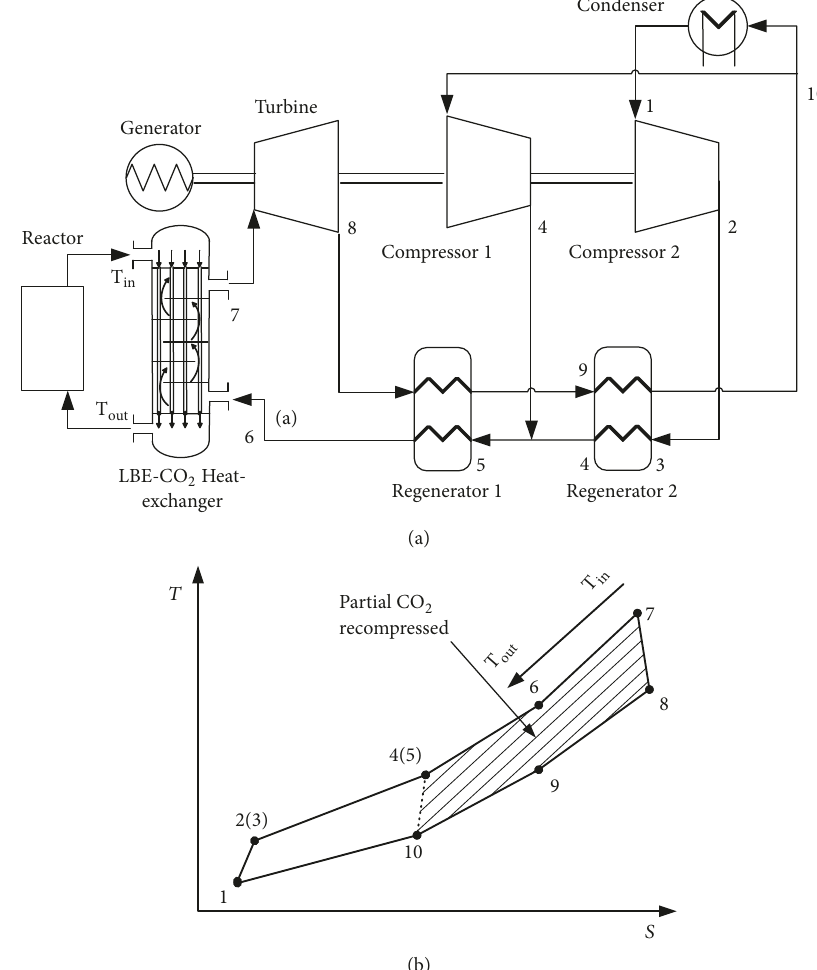
Figure 2: (a) System diagram of recompression Brayton Cycle. (b) The temperature-entropy diagram of the system.